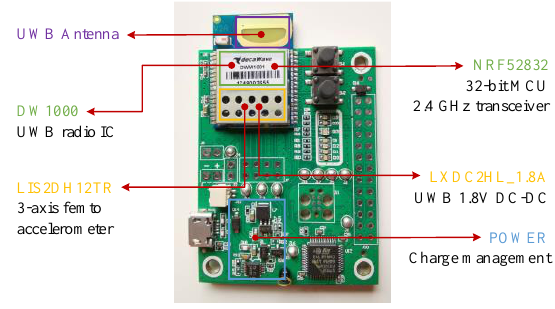
Figure 3. Photo of the Decawave UWB node. To verify the low delay performance of the node ranging, a specific electro-rotating actuator was designed to provide precise reference for the real speed of the nodes, as shown in Fig. 4. The actuator was driven by a DC motor with programmable speed. We adjusted the linear velocity of the marked nodes to approximately 5 m.s -1 . By optimizing the firmware, a measuring sampling rate of around 256 Hz can be obtained between one tag and two anchors.